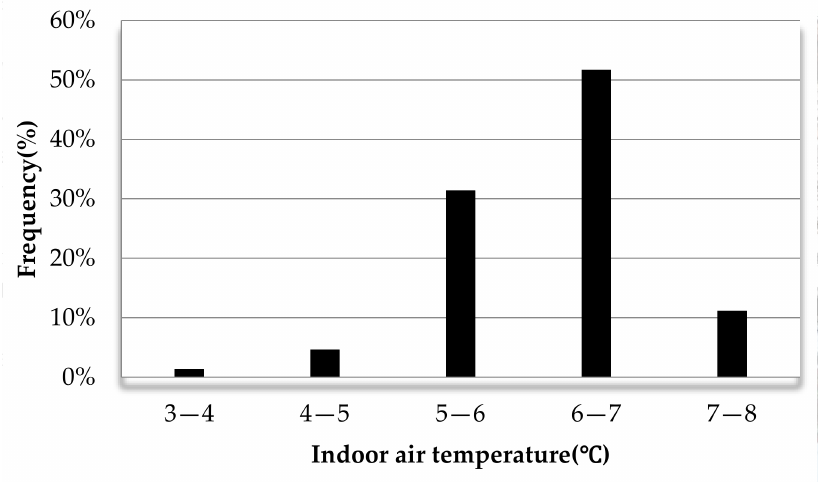
Figure 7. Frequency of the indoor air temperature in winter.